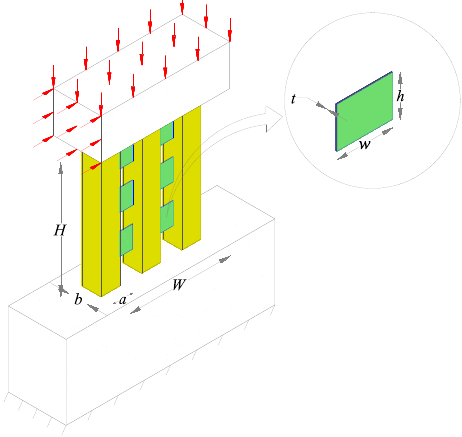
Figure 6. Geometric parameters investigated in this